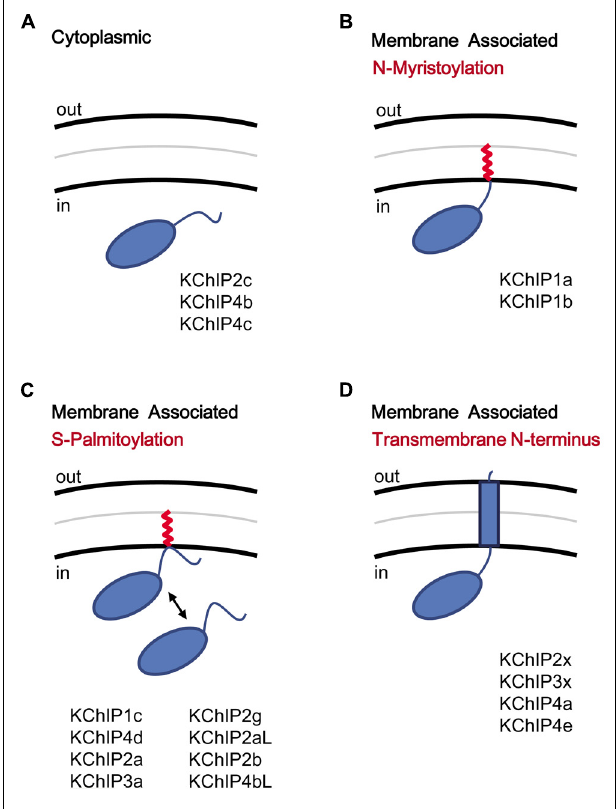
FIGURE 4 | KChIP N-terminal variants and the motifs coding for membrane association. KChIPs can be freely cytoplasmic or membrane associated. (A) Cytoplasmic KChIPs lack the sequence motif to allowing anchoring of the KChIP molecule to the membrane. (B) Membrane association by N-myristoylation.The myristoylate group (red) is attached to a glycine residue at position 2. (C) Membrane association by S-palmitoylation.The palmitoylate group (red) is attached to a reactive cysteine within the N-terminal domain via a reversible reaction and induces membrane association. (D) Membrane association by insertion of a transmembrane N-terminal segment. Multiple N-terminal variants possess a highly hydrophobic segment that traverses the membrane. Aside from functioning as a membrane anchor, the transmembrane segment also modulates surface trafficking and channel